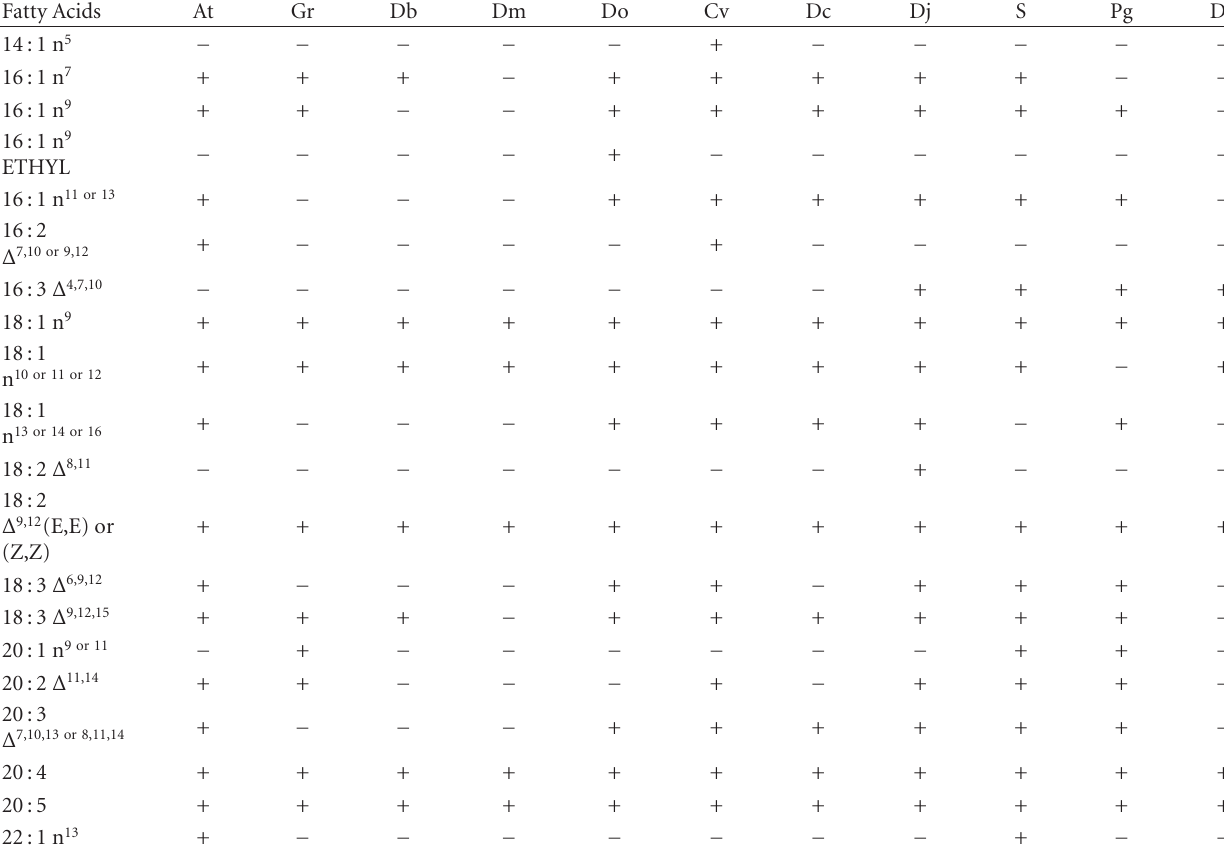
Table 3: Unsaturated fatty acids founded in the eleven seaweeds studied.